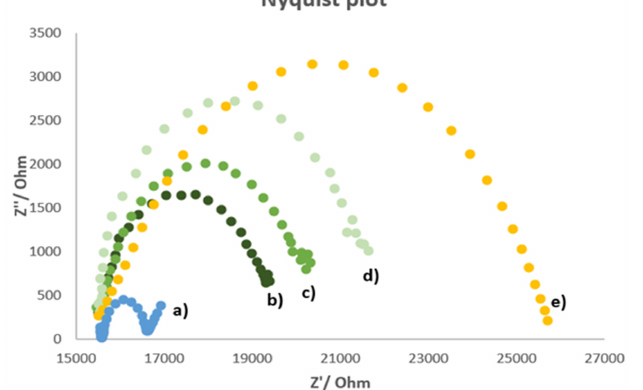
Figure 2. Nyquist plot of ( a ) bare electrode, ( b ) MIP-modified electrode, ( c ) MIP-modified electrode charged with 10 − 6 M atrazine, ( d ) MIP-modified electrode charged with 7.7 × 10 − 6 M atrazine, ( e ) NIP-modified electrode. Measurements performed in 5 mM K 3 Fe(CN) 6 /0.1 M KCl solution; frequency range 100 kHz ÷ 10 mHz; signal amplitude = 50 mV.